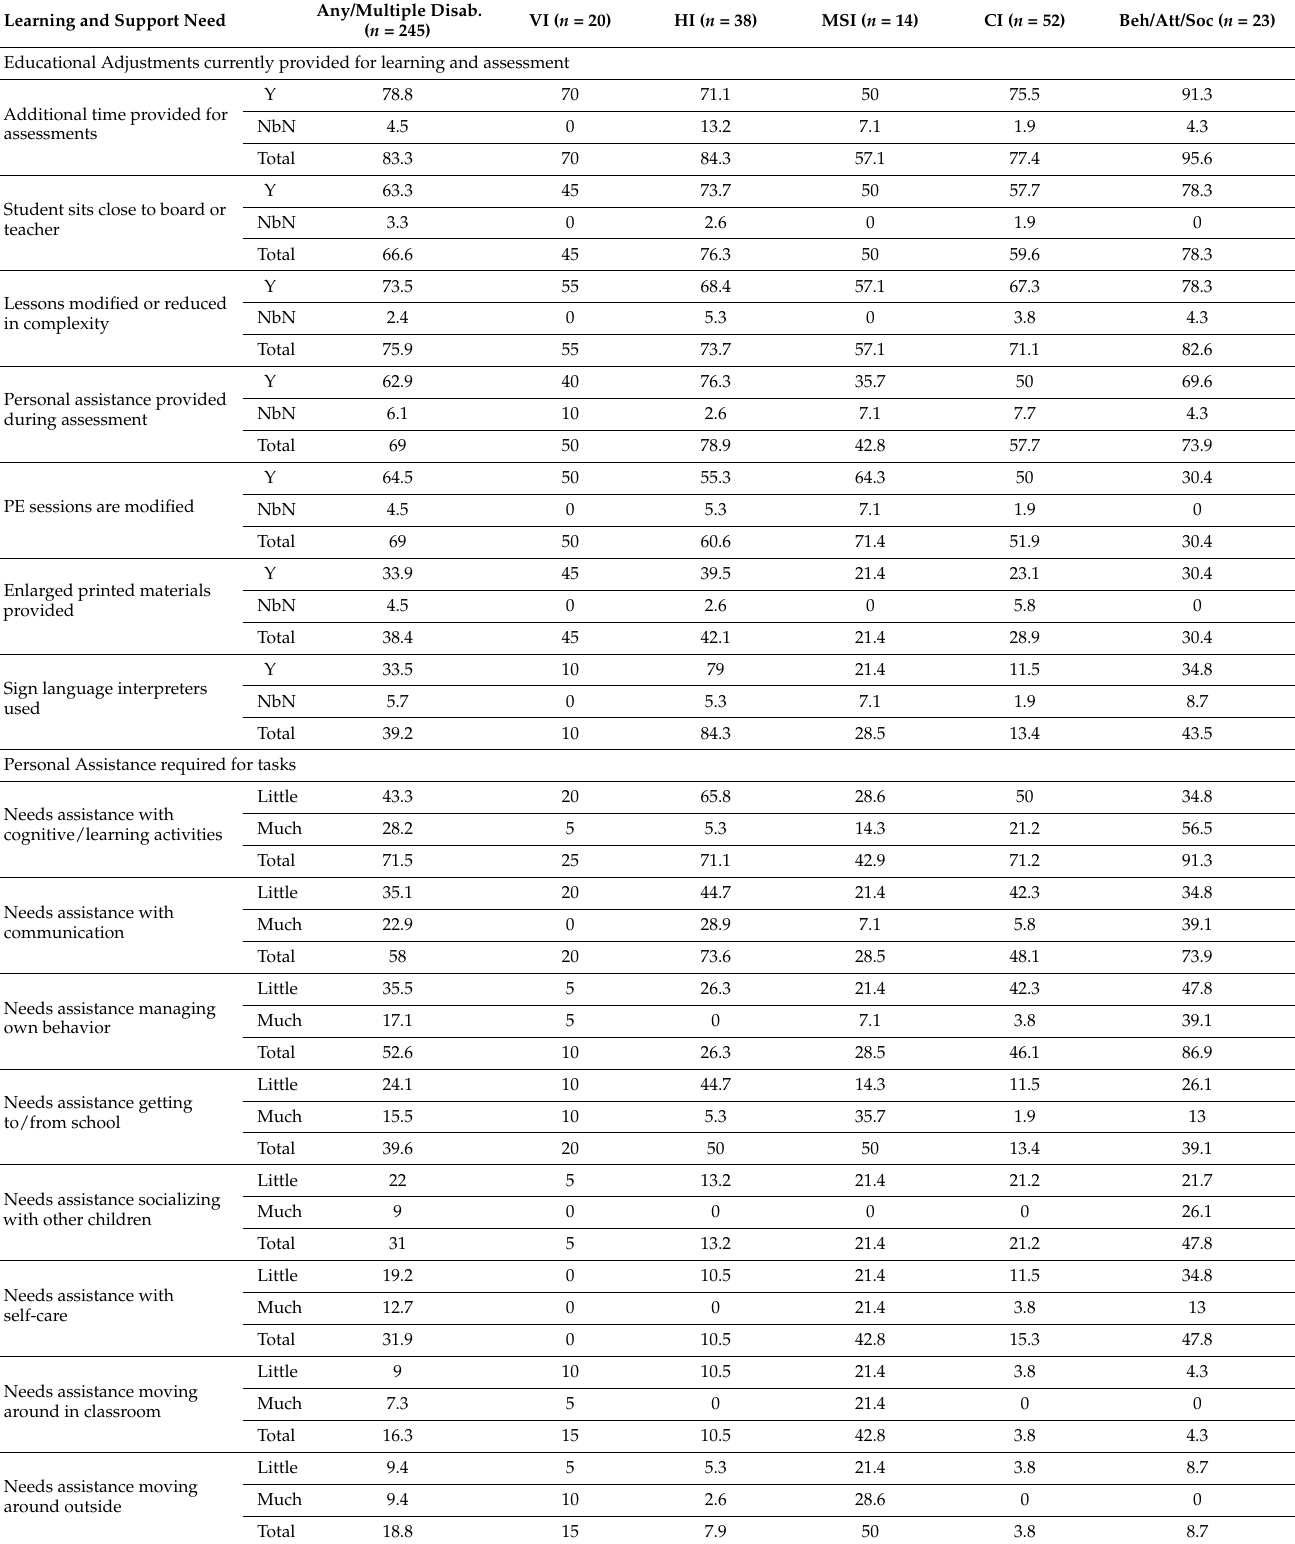
Table 1. Learning and support needs as a percentage of children with disability, including any/multiple disability types and children with single-disability